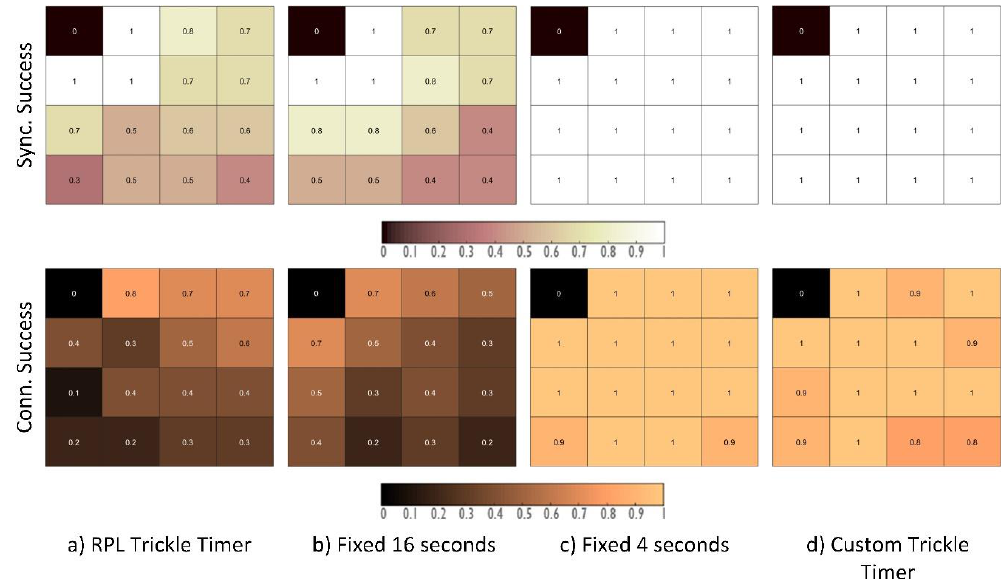
Figure 10 . The probability of synchronization and connection success for different EB period configurations.